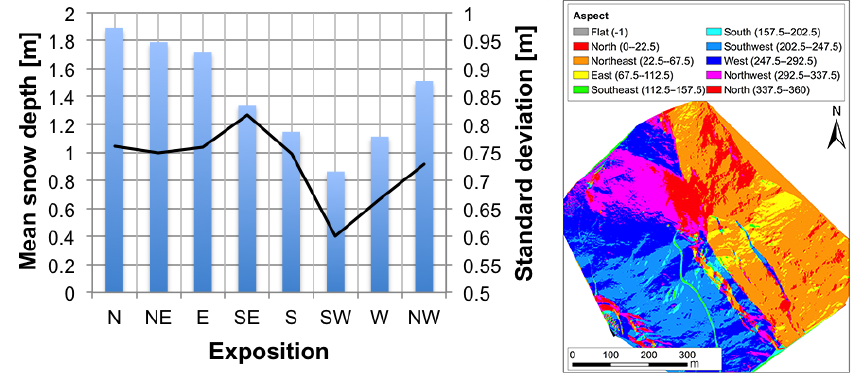
Figure 7. Statistical evaluation of the mean HS (bars) and its standard deviation (line), classified by the exposition (left panel) and exposition map (right panel).